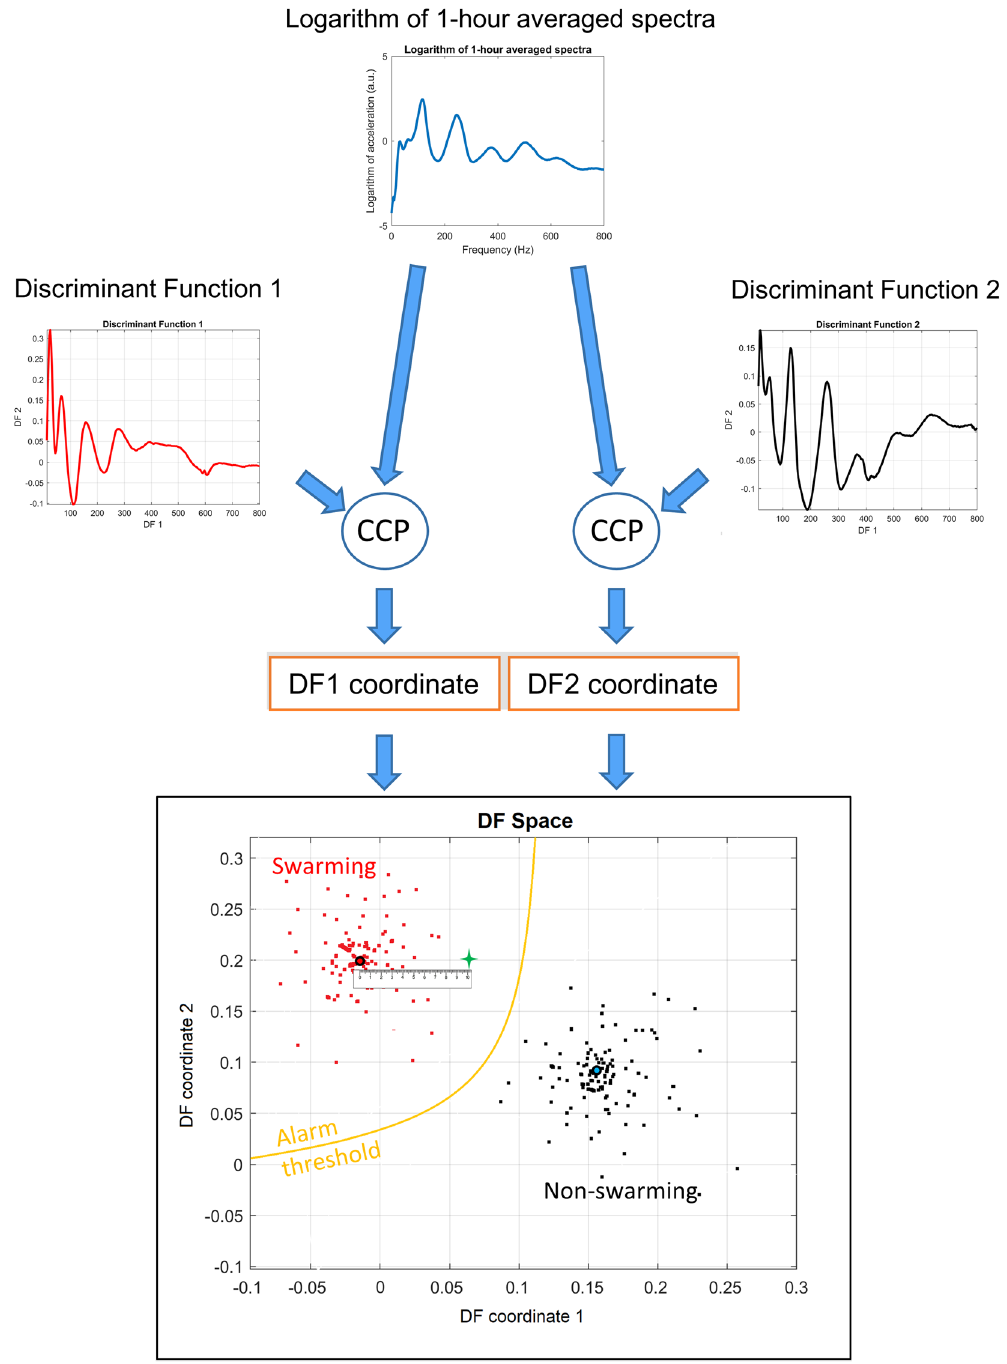
Figure 1. The instantaneous alarm procedure. The images in Fig. 1 are solely for illustrative purposes. This figure depicts the processing for the detection of swarming in the post-training phase. Each hour-long averaged spectrum is compared, using the cross-correlation product (CCP), to a pair of DF curves, as determined by the DFA algorithm (see Fig. 2), providing the co-ordinates for a single point in the DF space (green ‘ + ’ sign). The Euclidean distance to the swarming and non-swarming centroids (the central point of all swarming and non- swarming spectra, used in the training phase, respectively shown as a red dot with black outline and green dot with blue outline) are calculated. The ratio of these distances provides our “criterion value”, and is compared to an optimised threshold value (see Methods) to determine if it is the spectrum of a colony intending to swarm or not, i.e. if the point in DF space lies within the upper left “swarming area” bordered by the yellow line. In this figure, for ease of representation, we give an example using two discriminant functions, however, in this study, three discriminant functions were used. Plots used in the creation of this figure were generated using the MATLAB (R2018b) software